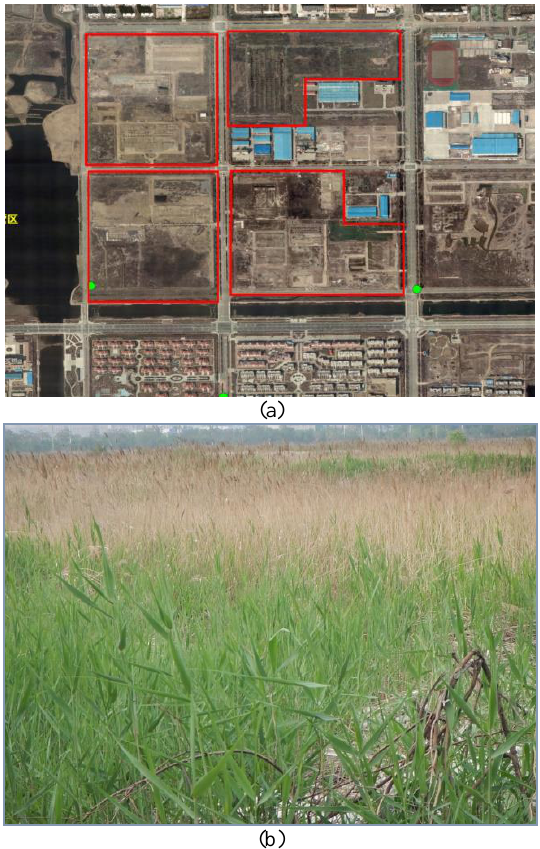
Figure 4. Inconsistent collection of the same object in two types of data （ a ） Construction land in DLTB, grassland in LCA; the red lines are the boundaries; the green points are the sample points (b) Field photos of sample points